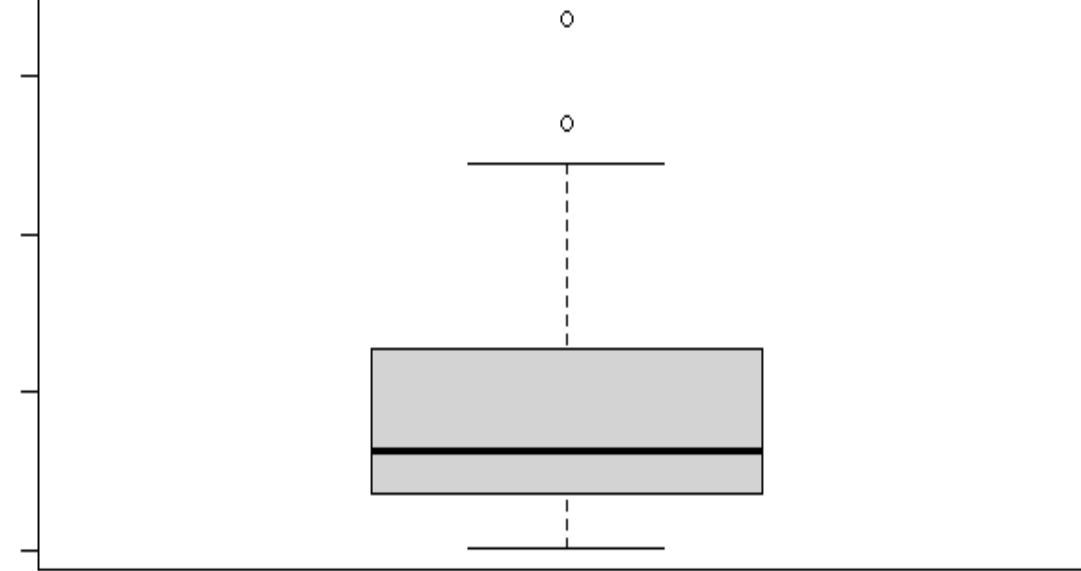
Figure 4. Outliers in a scatterplot. (a) Point Anomaly In a point anomaly, there are single independent data instances that show deviation in their behaviour compared to other data instances in the dataset. In Figure 5, samples of point anomalies are shown in 2D (two ‐ dimensional space).